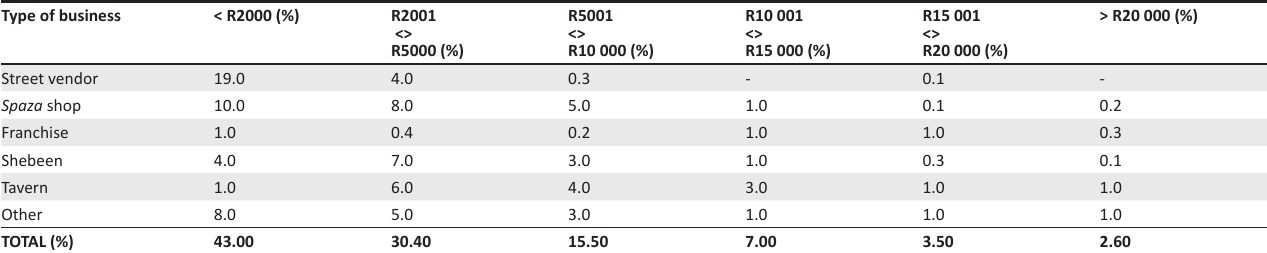
TABLE 4: Cross-analysis of income and type of business.